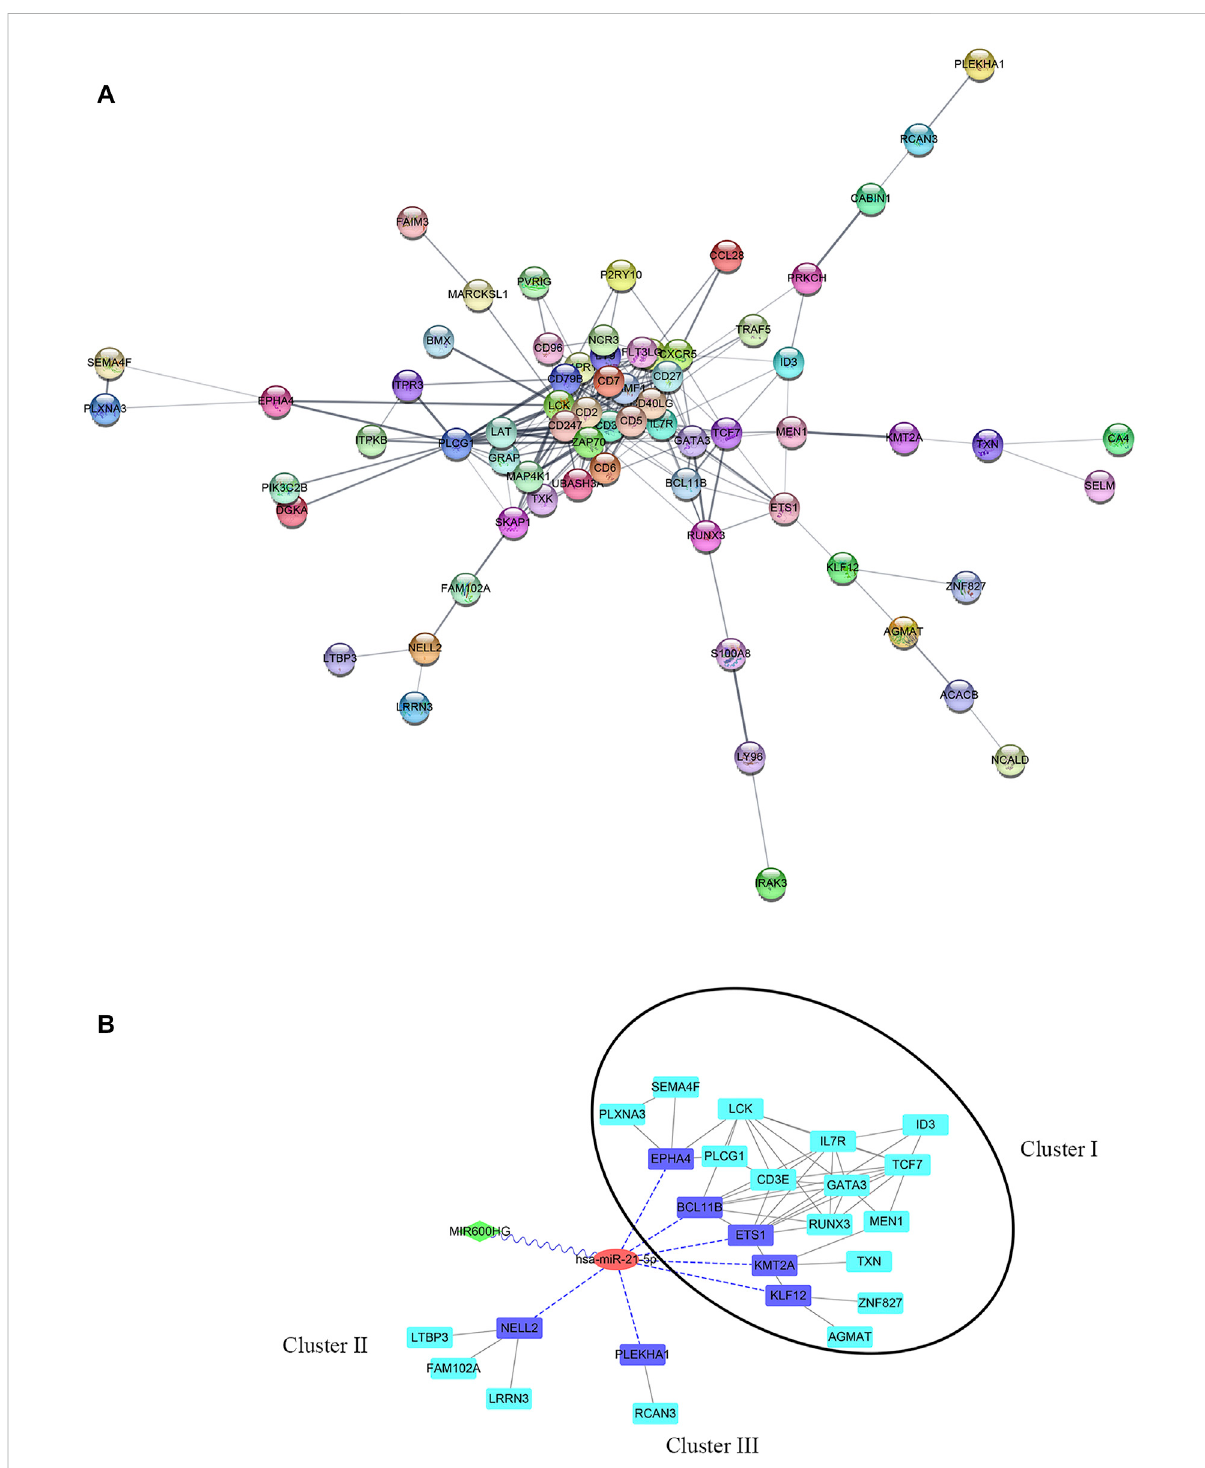
FIGURE 5 (A) PPI network of hub genes in the brown module. (B) ceRNA network. The green diamond node represents lncRNA, the red circular node represents miRNA, the blue square nodes represented the targeting mRNAs of hsa-mir-21-5p, and the turquoise square nodes represent the fi rst- levelneighborsofthetargetingmRNA.Thegreyedgesindicateinteractionsbetweenproteins.ThebluedottededgesindicatetargetingfrommiRNA to mRNAs. The wavy edges indicate targeting from lncRNA to miRNA. The black circular frame indicates the major gene cluster in the ceRNA